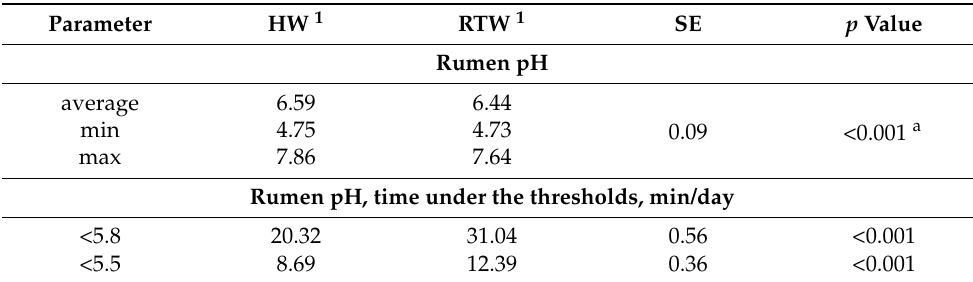
Table 4. Ruminal parameters: ruminal